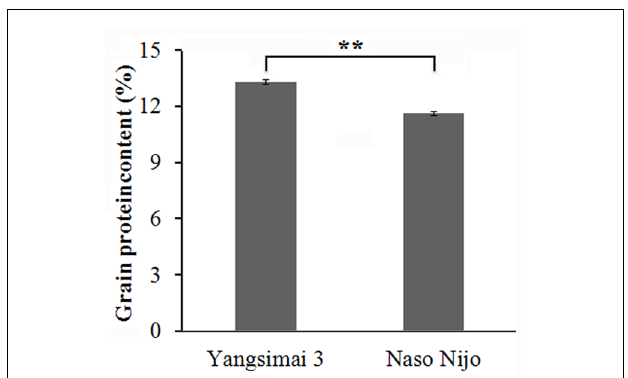
FIGURE 1 | Differences in grain protein content between two barley cultivars. ∗∗ p <